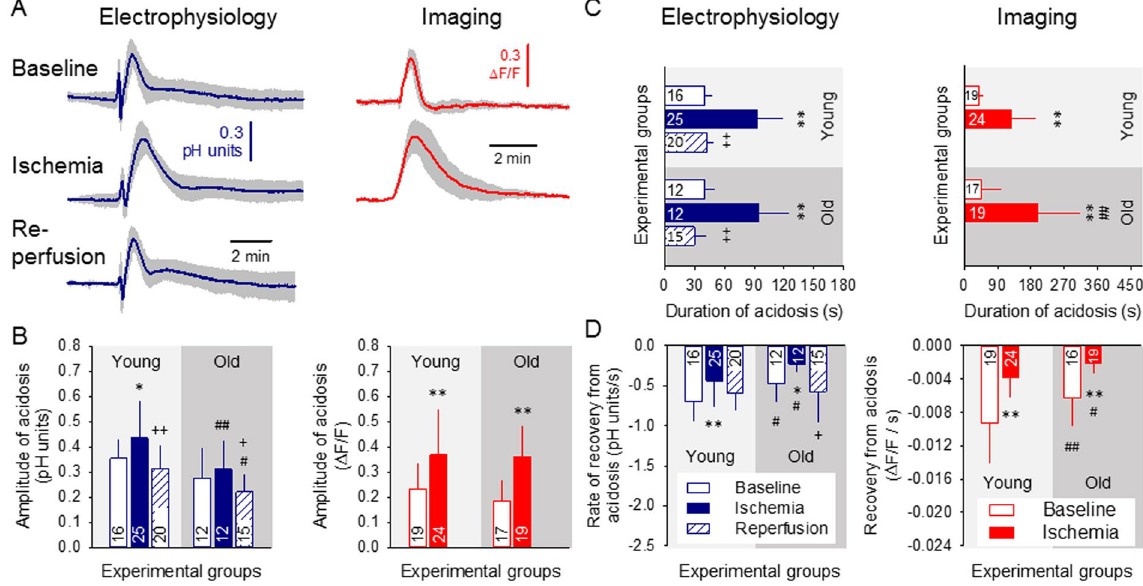
Figure 3. Tissue acidosis with spreading depolarization (SD) is augmented during ischemia, and recovers slower in the aged brain. In each panel, data obtained with pH-sensitive microelectrodes are shown on the left, and data derived from Neutral Red fluorescence imaging are shown on the right. ( A ) Tissue pH variations associated with SDs occurring during the three subsequent phases (i.e. baseline, ischemia, reperfusion) of the experiments. Each trace is the average of individual ones taken from separate animals, and are presented as mean ± stdev (n = 6/8). ( B ) Relative amplitude of acidosis. ( C ) Duration of acidosis at half amplitude. ( D ) Rate of recovery from acidosis (i.e. slope). Data are given as mean ± stdev; sample size (number of events) is shown in each bar. For the evaluation of statistical significance, a two-way analysis of variance (ANOVA) paradigm considering age and the phase of the experiment as its factors was applied. Level of significance for the ANOVA was defined as * p < 0.05. Significant differences between groups were determined by a Fisher post hoc test as follows: * p < 0.05 and ** p < 0.01, vs. respective Baseline; + p < 0.05 and ++ p < 0.01, vs. respective Ischemia; # p < 0.05 and ## p < 0.01, vs. respective